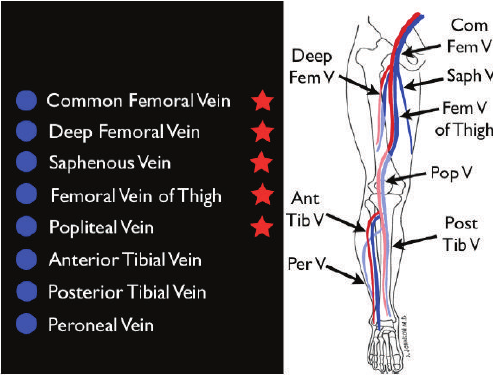
Figure 27: Limited leg deep venous thrombosis exam (starred veins).